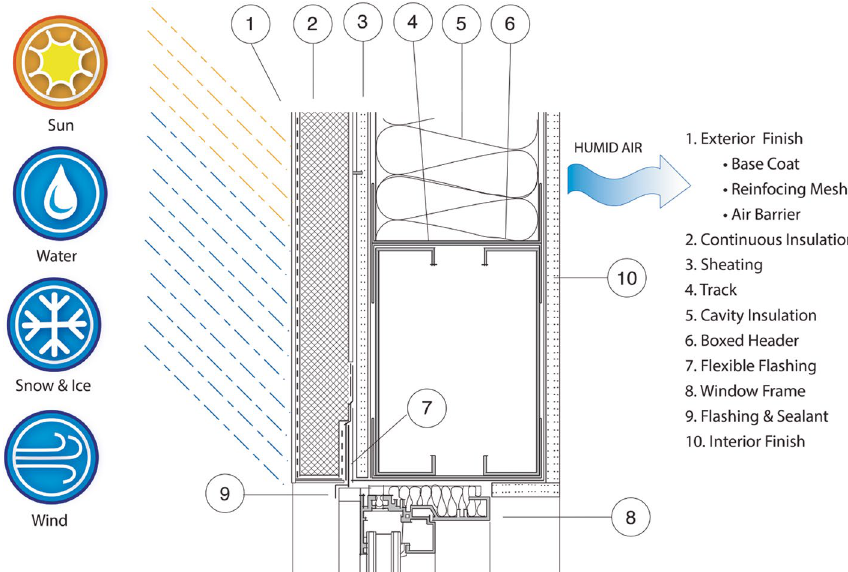
Fig. 3 Typical EIFS wall section. EIFS is an economical exterior cladding system that can be compromised by ultraviolet sunlight and weathering from rain, snow, ice, and wind introducing cold dry air during winter months or warm humid air during summer months into interior rooms. (Source: the